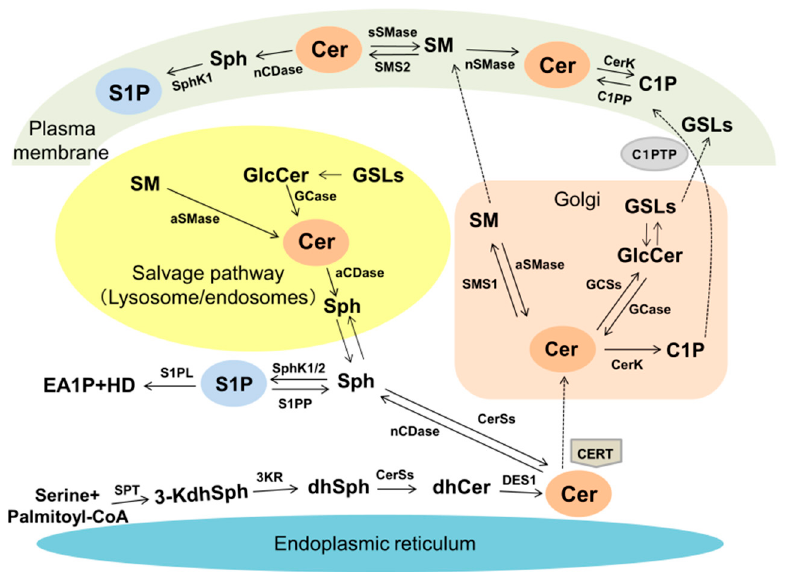
Figure 1. Simplified metabolic pathways of sphingolipids. Cer is de novo synthesized at the surface of the ER by condensation of serine and palmitoyl-CoA mediated by SPT, forming 3-KdhSph. 3-KdhSph is then reduced to dhSph by 3-KR. DhSph is the substrate of CerS, forming dhCer which is converted into Cer by DES1. Cer is transferred to the Golgi by CERT or vesicular trafficking and converted into SM by SMS or C1P by CerK. Cer is converted into GlcCer by GCSs and further metabolized into complex GSLs. Cer is also phosphorylated into C1P by C1PP. GSLs and SM in the Golgi are transferred to the plasma membrane by vesicular trafficking, where SM is converted into Cer by sSMase or nSMase. C1P is transferred to the plasma membrane by C1PTP. In the plasma membrane, Cer can be produced from SM via sSMase and converted into Sph by nCDase or C1P via C1PP.